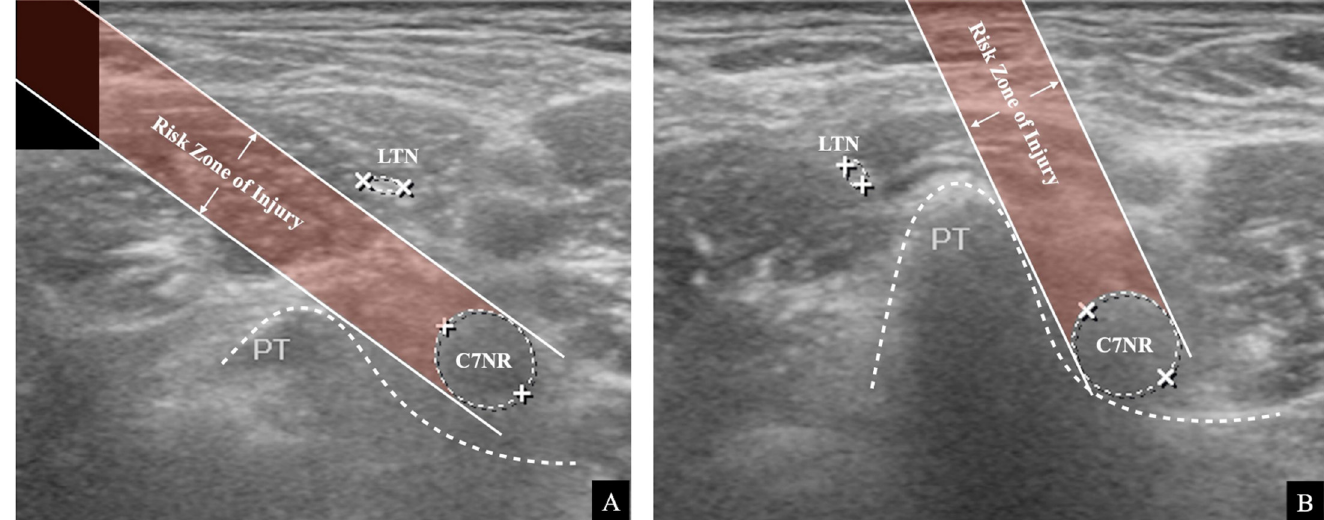
Figure 5. Cases in which the long thoracic nerve (LTN)’s location is outside of the risk zone. ( A ) The LTN is anterior to the risk zone. The C7 transverse process’s posterior tubercle (PT) shape is shallow, so the simulated needle’s trajectory line is relatively horizontal. ( B ) The LTN is posterior to the risk zone. The needle’s trajectory line is relatively vertical due to the prominent PT, and the LTN travels behind the PT.